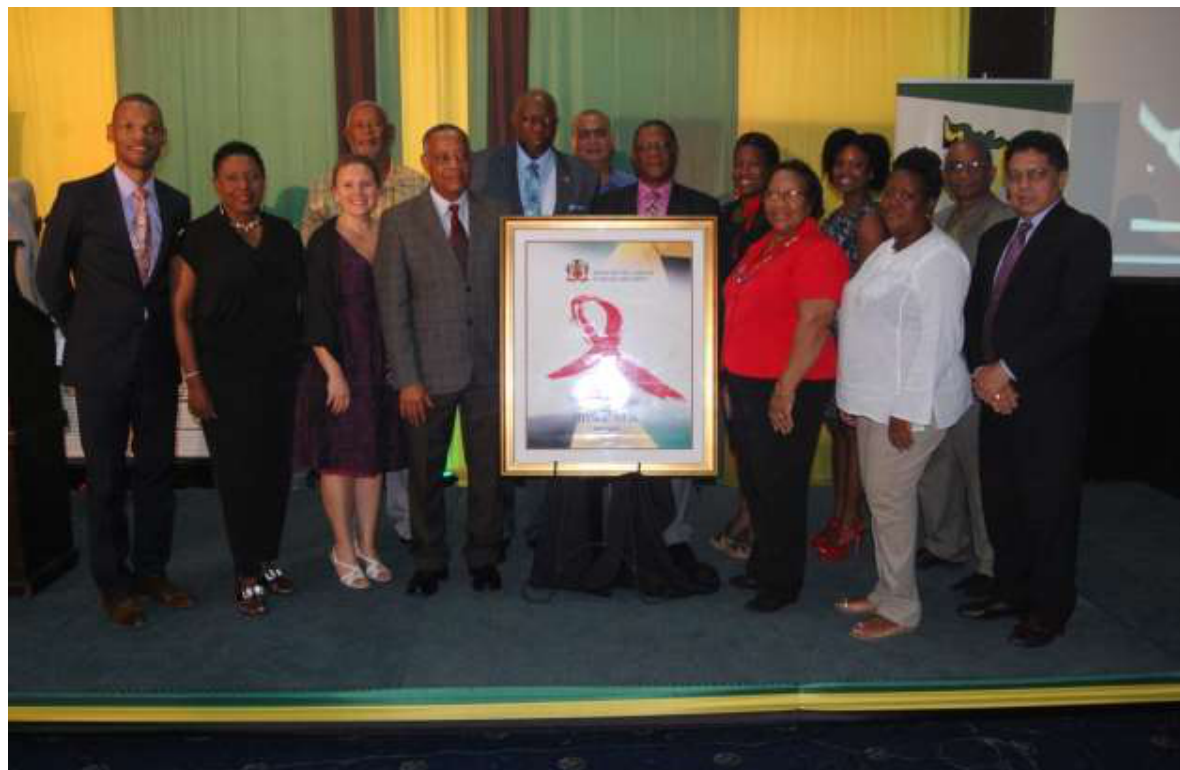
Figure 9. Launch of the National Workplace Policy on HIV and AIDS – White Paper and the OSH Profile of Jamaica (December 2013) featuring members of Parliament & Government, Union Representatives, Private Sector Representatives, International Funders and the Network of